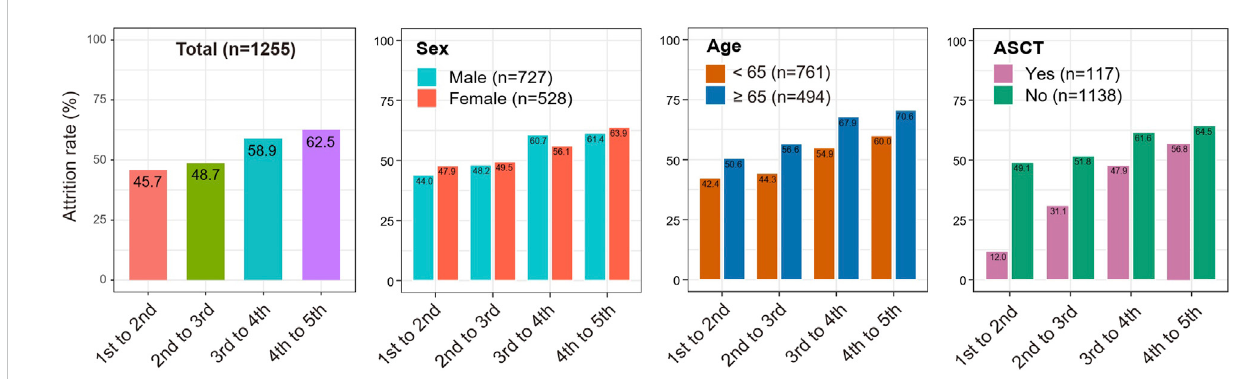
FIGURE 3 The detailed attrition rate between distinct LOTs in speci fi c clinical subgroups.